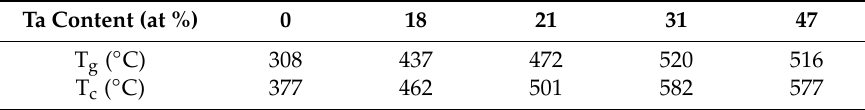
Table 2. Crystallization and glass transition temperatures as a function of Ta content.